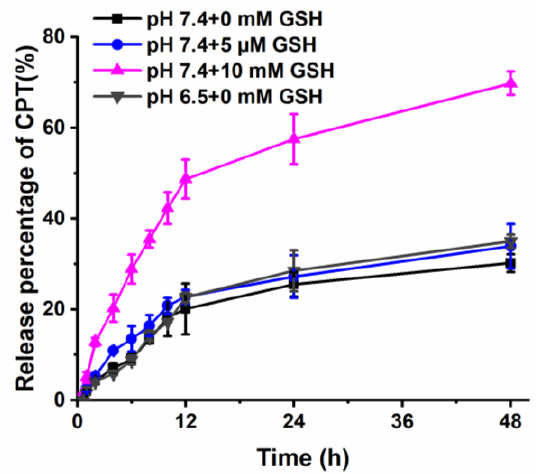
Figure 3. In vitro CPT release profiles from GT-ss-CPT NPs under different GSH concentrations and pH values ( n = 3).